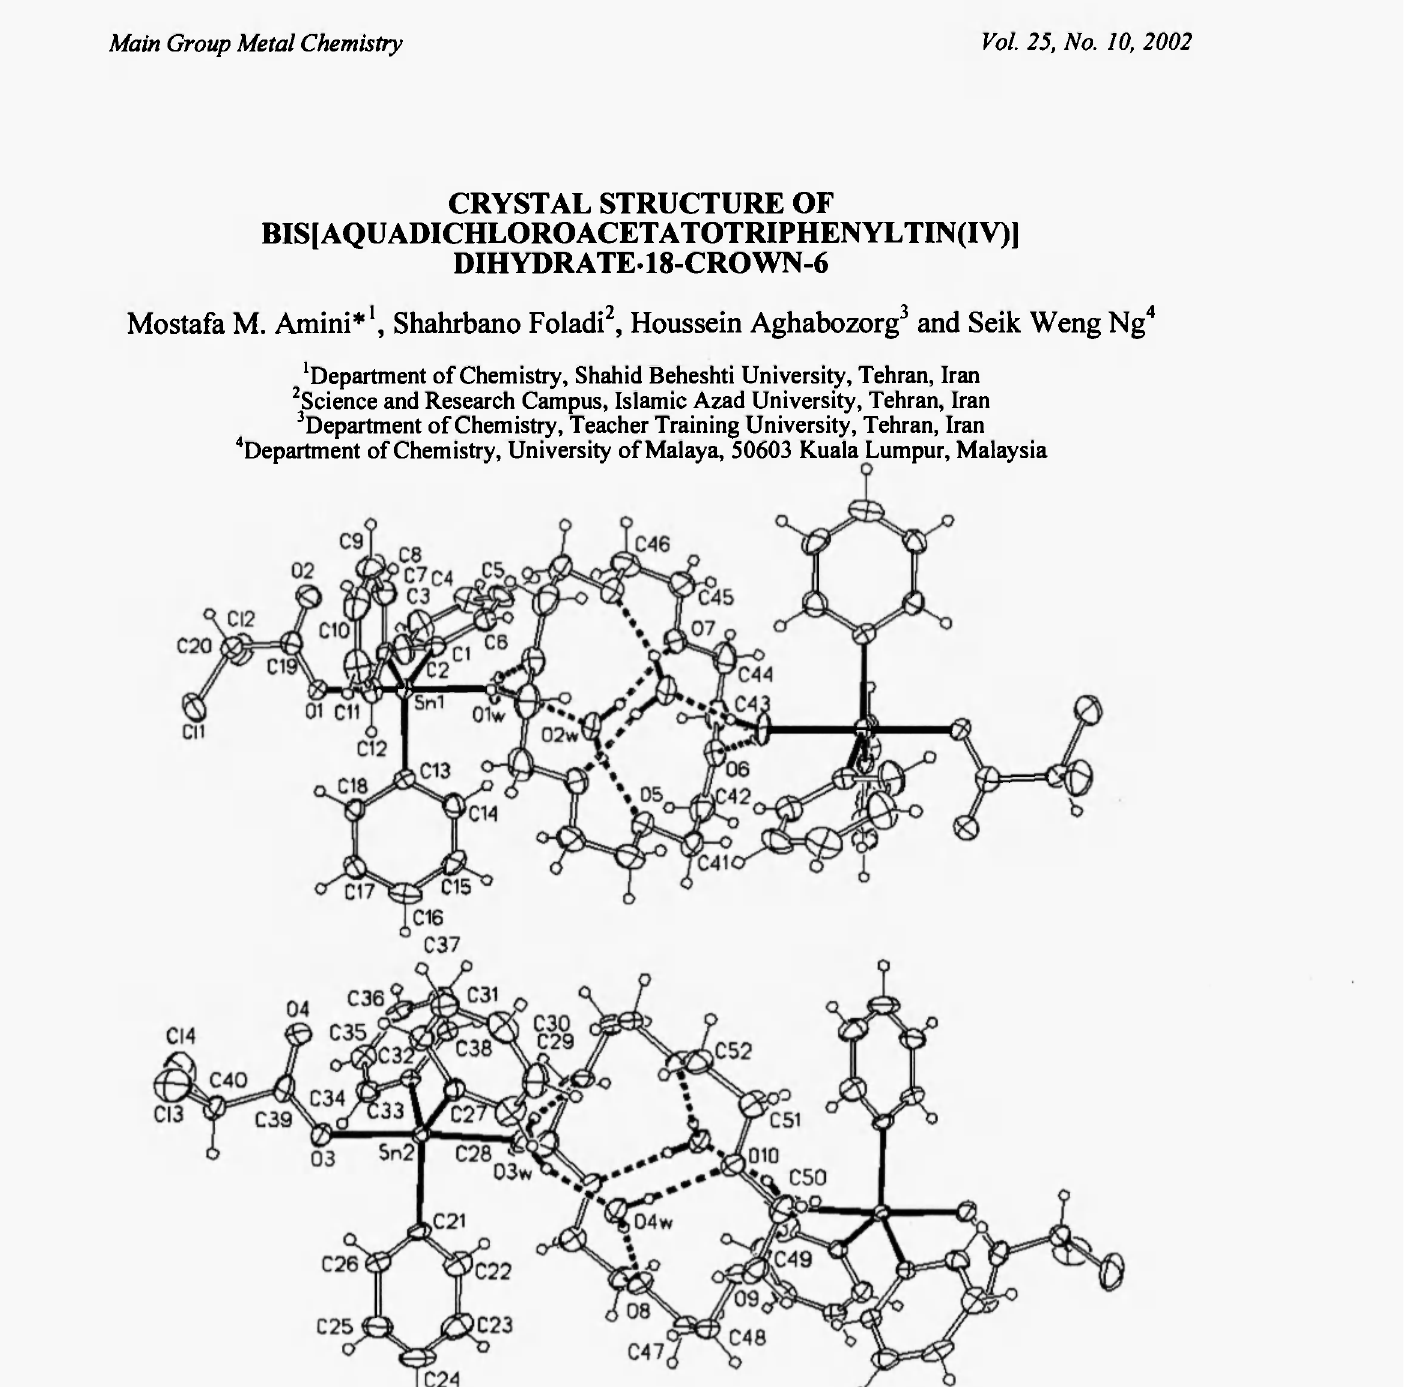
Figure 1. Geometry of the tin atoms in the two independent [(C6H5)3Sn0 2 CCHCl2H 2 0] 2 2Η 2 0^ 2 Η 24 0 6 units. Selected bond distances and angles: Snl-Cl = 2.173(3), Snl-C7 = 2.147(3), Snl-C13 = 2.168(3), Snl-Ol = 2.178(5), Snl-Olw = 2.309(5), Sn2-C21 = 2.159(4), Sn2-C27 = 2.167(3), Sn2-C33 = 2.173(3), Sn2-03 = 2.193(5) Sn2-03w = 2.335(5) A; Cl-Snl-C7 = 127.4(2), Cl-Snl-C13 = 115.4(2), Cl-Snl-Ol = 94.0(2), Cl-Snl-Olw = 88.9(2), C7-Snl-C13 = 116.5(2), C7-Snl-01 = 95.2(2), C7-Snl-01w = 81.8(2), C13-Snl-01 = 88.8(2), C13-Snl-01w = 91.3(2), Ol-Snl-Olw = 176.7(2), C21-Sn2-C27 = 116.1(2), C21-Sn2-C33 = 125.5(2), C21-Sn2-03 = 88.0(2), C21-Sn2-03w = 88.1(2), C27-Sn2-C33 = 117.5(2), C27-Sn2-03 = 98.5(2), C27-Sn2-03w = 88.8(2), C33-Sn2-03 = 92.9(2), C33-Sn2-03w = 84.3(2), 03-Sn2-03w = 172.7(2)°.